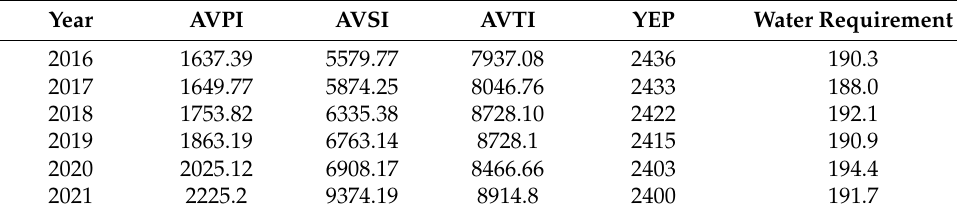
Table 6. The related data in Inner Mongolia autonomous